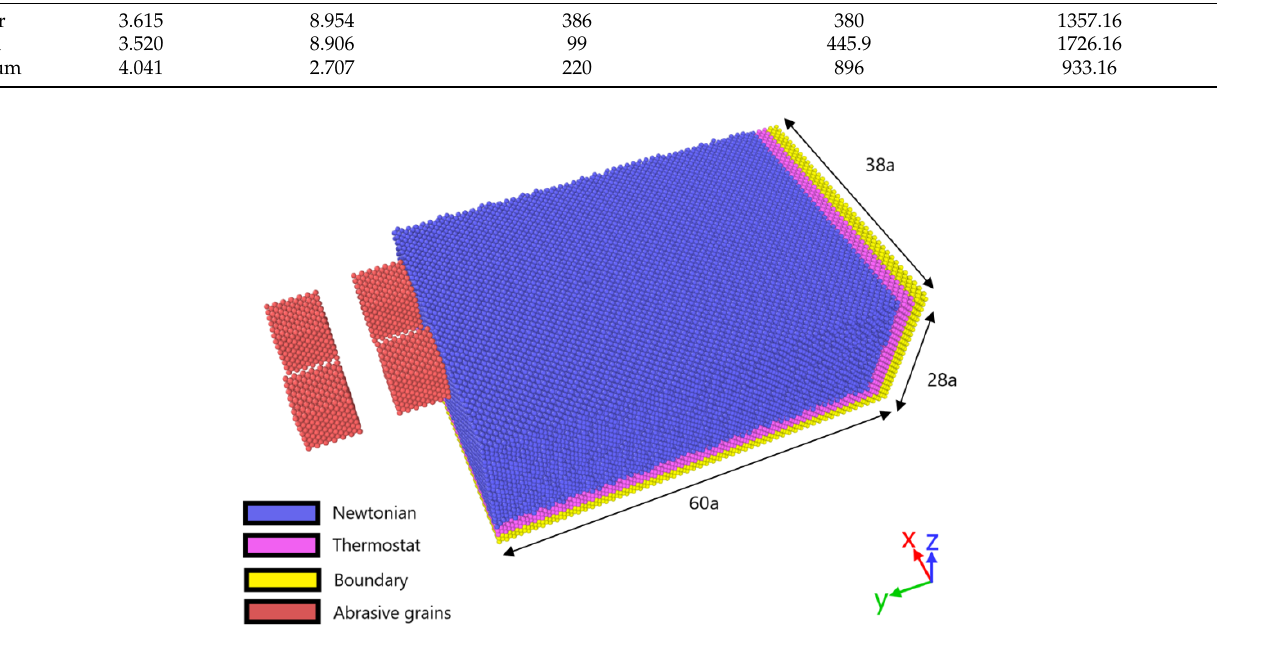
Table 1. Properties of materials used in the simulations [35].